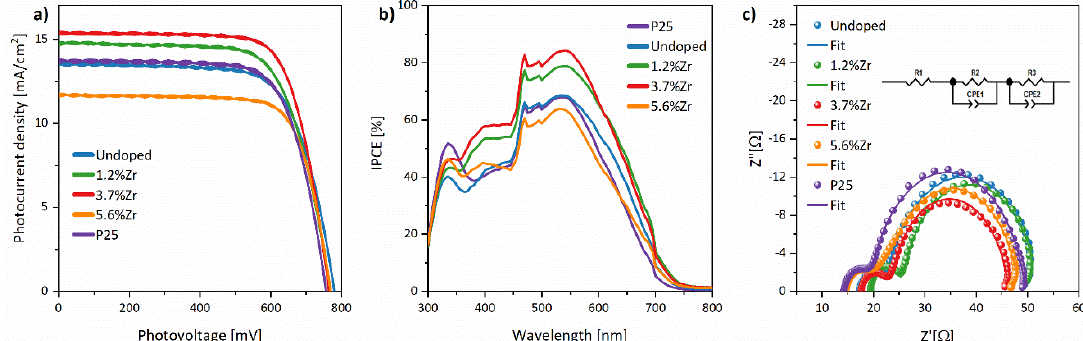
Figure 13. J-V characteristics ( a ), IPCE spectra ( b ), and Nyquist plots with inserted equivalent circuit scheme used to fit the EIS spectra ( c ) of investigated DSSCs.